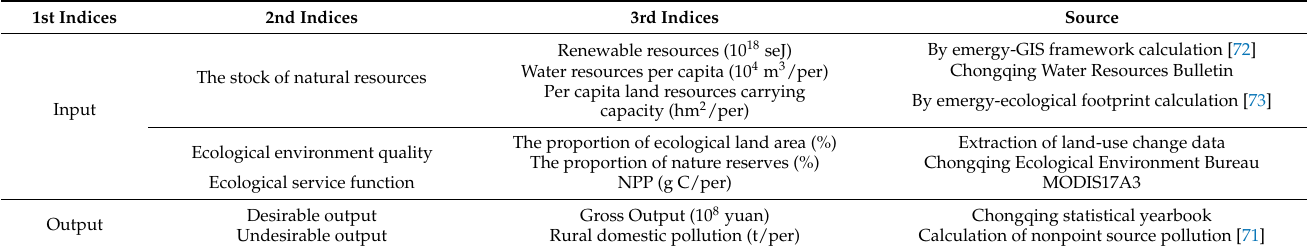
Table 1. Evaluation index system of